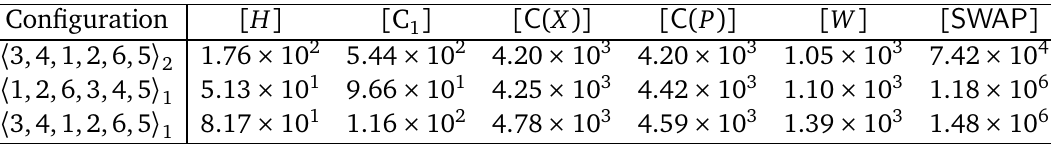
Table 2: Optimal MZM labeling configurations for two-sided 〈 3,4,1,2,6,5 〉